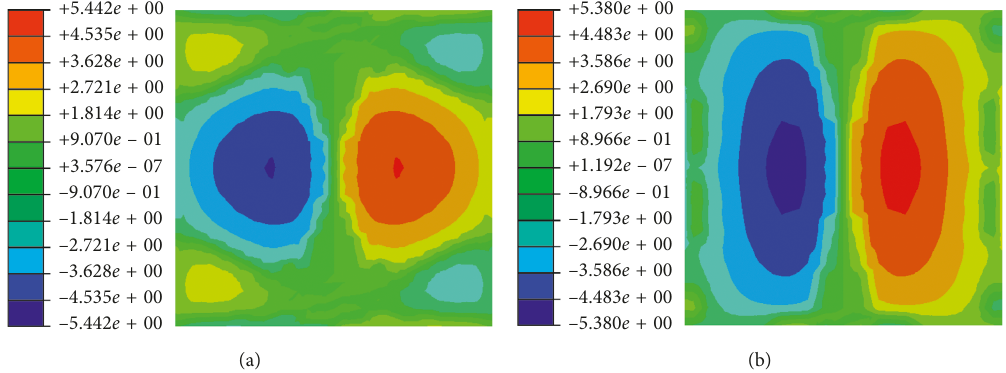
Figure 10: Cyclic stress invariant at the base of the soil foundation. (a) Configuration-1. (b) Configuration-2.